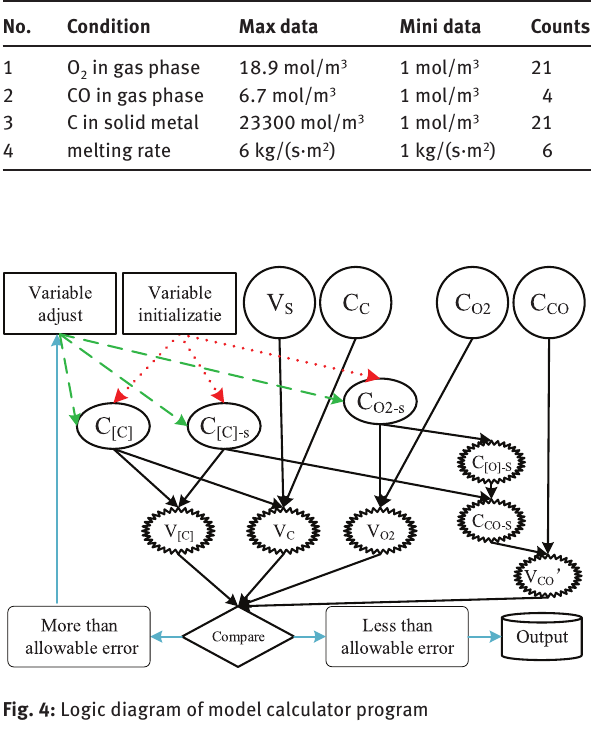
Fig. 4: Logic diagram of model calculator